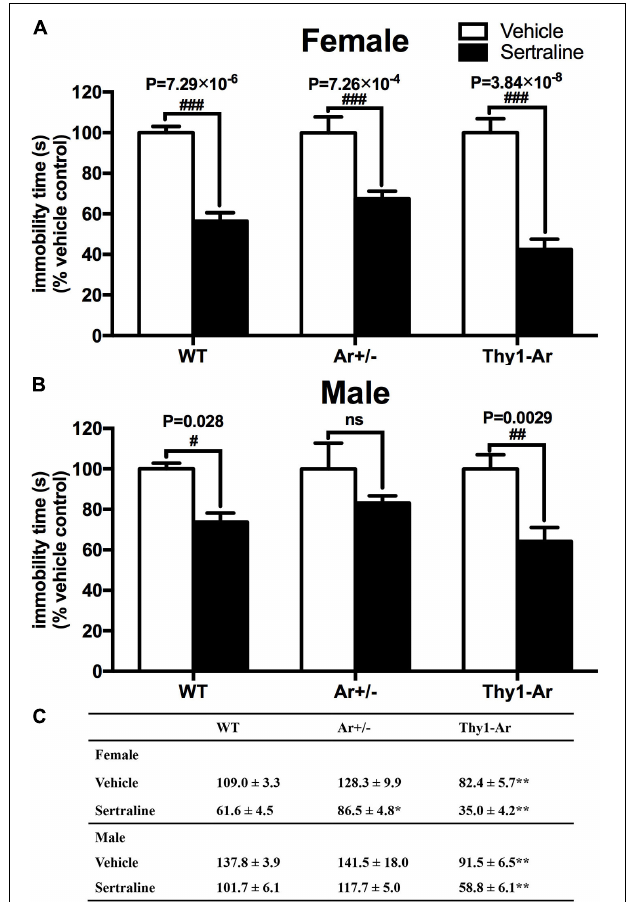
FIGURE 1 | Enriched brain estrogen synthesis expressed antidepressive-like behavior and promoted antidepressive effect of sertraline in both male and female mice. Effect of sertraline on percentage change of immobility time during the FST from vehicle treated mice in both (A) females and (B) males. Mean immobility duration (C) in sec. of female and male mice after sertraline administration or vehicle during the FST. Data represent means ± SEM ( N = 6–7 mice/group), as evidenced by two-way ANOVA. # P < 0.05, ## P < 0.01, ### P < 0.001 versus vehicle-treated group; ∗ P < 0.05, ∗∗ P < 0.01 versus WT